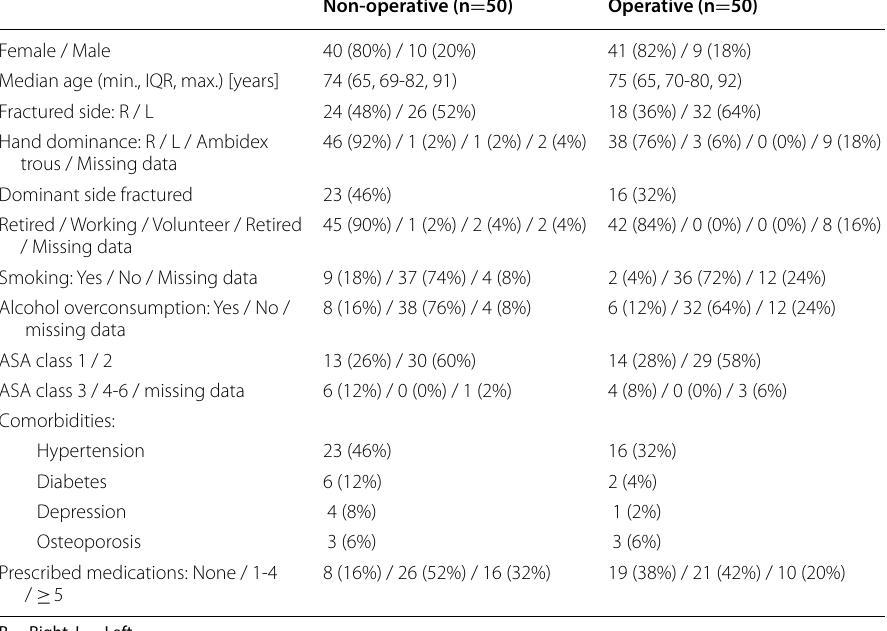
R Right, L Left = = A fracture in an ambidextrous patient was not considered a fracture of the dominant side. Alcohol overconsumption was defined as more than 7 units/week for females and 14 units/week for